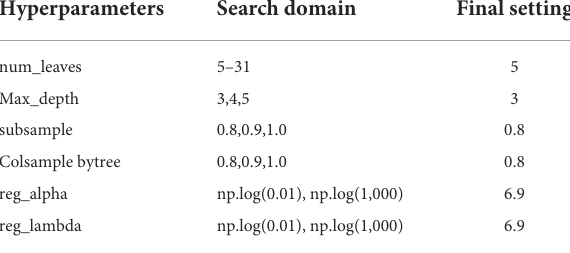
TABLE 4 TBAAD-AKI